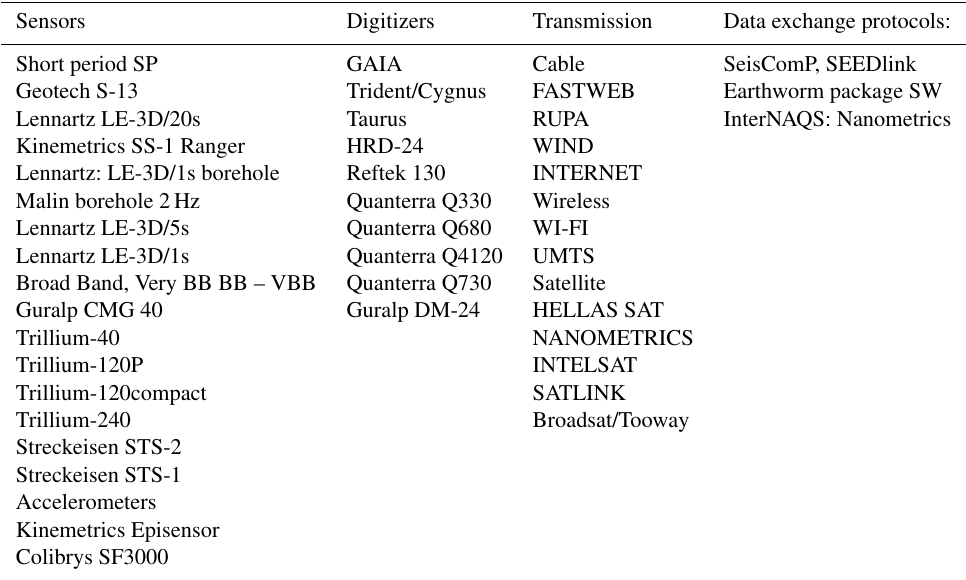
Figure 2. A site of the RSN-RING networks equipped with broad-band velocimeter, accelerometer and GPS antenna. Table 1. Instrumentation – data transmission and data exchange protocols of